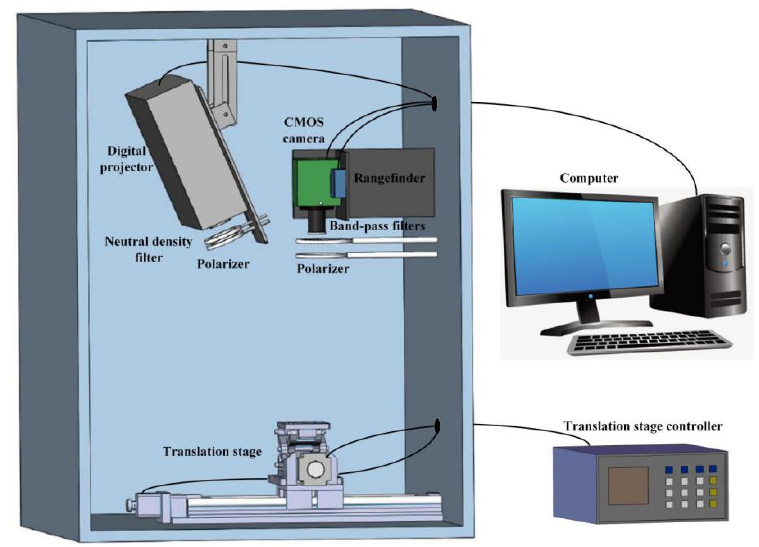
Figure 1. Schematic diagram of the developed SFDI system.